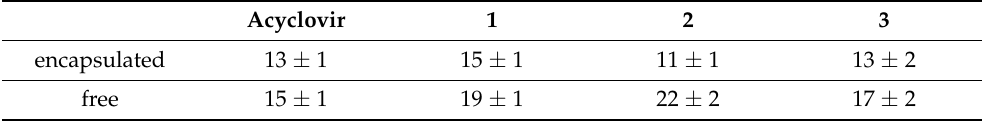
Table 2. Comparative analysis of CC50 ( µ M) values of acyclovir and 2-aminomethyl-3-hydroxy1,4 naphthoquinone derivatives, encapsulated and not encapsulated (free compounds), in liposomes performed in Vero cells.